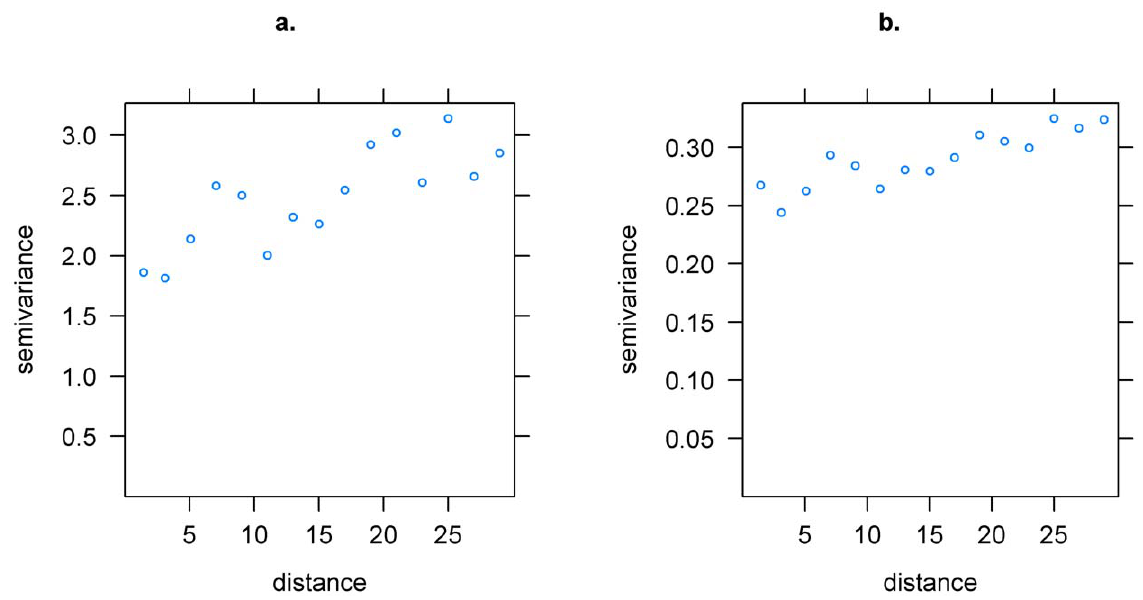
Figure 3. Residual variograms using Pearson residuals. Residual variogram from the non-spatial model (3a) [6] and the Bayesian spatial model (3b).